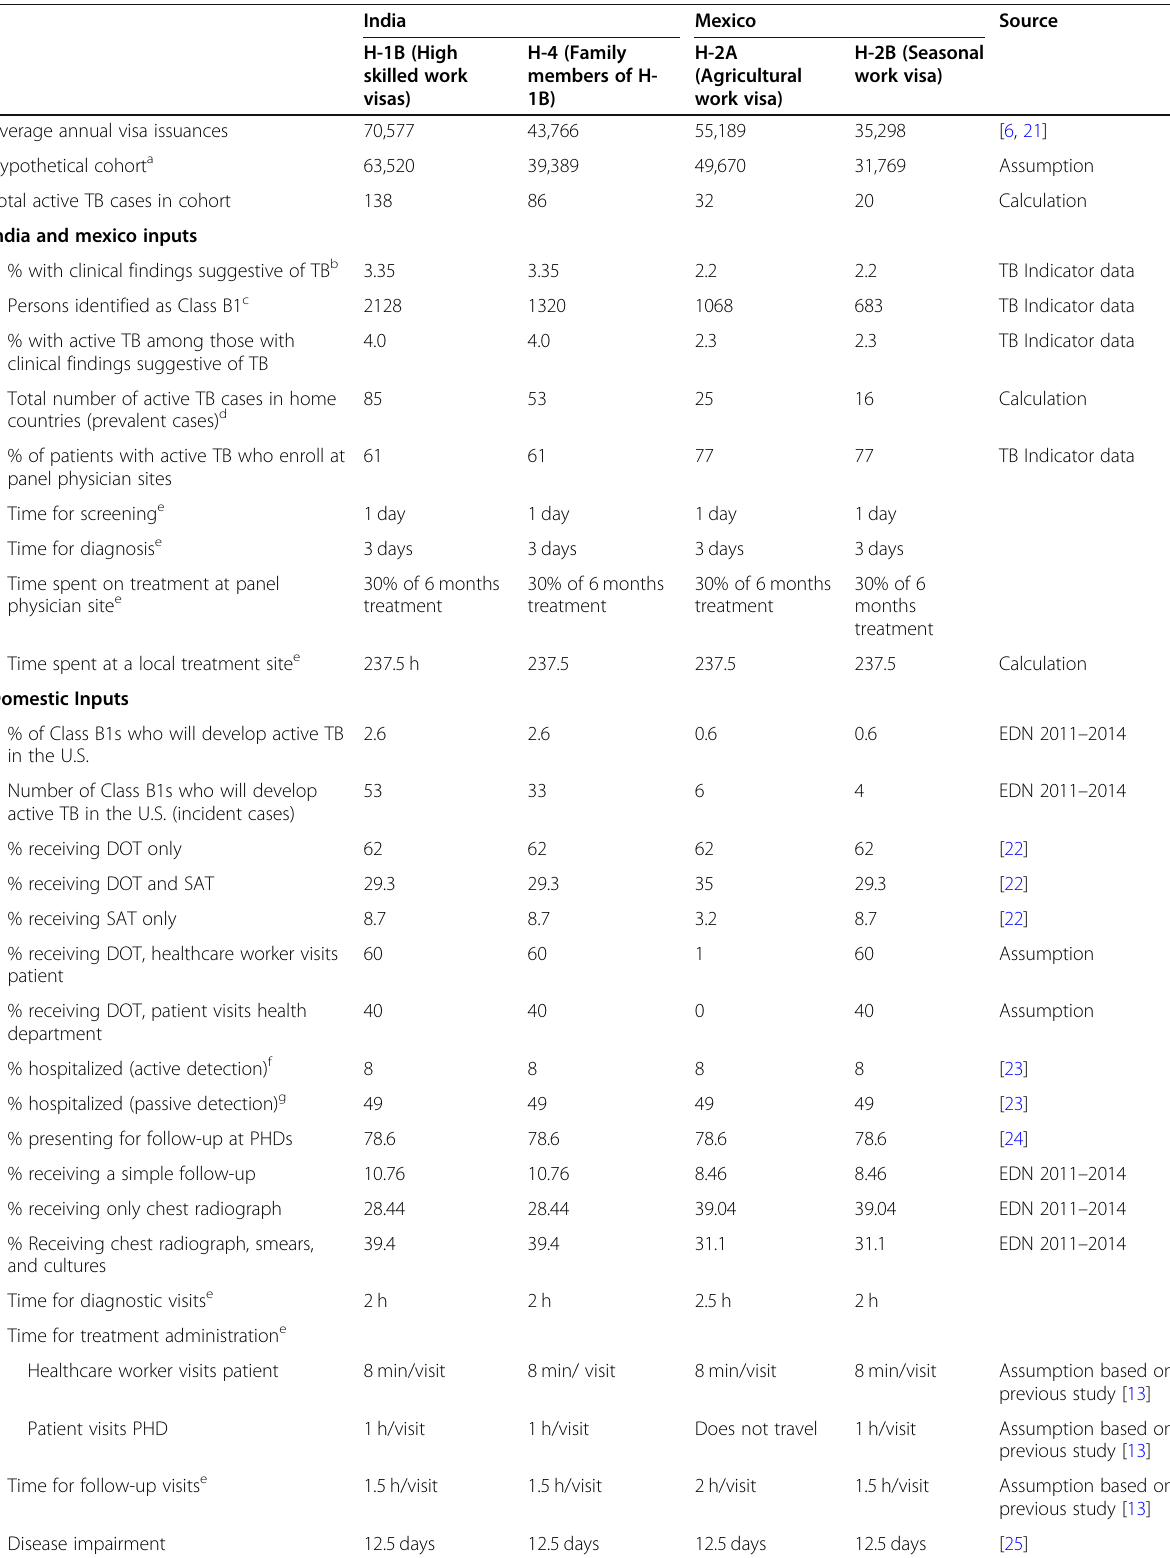
Table 1 Inputs to a model estimating costs of tuberculosis screening among Indian and Mexican nonimmigrant visa applicants, base